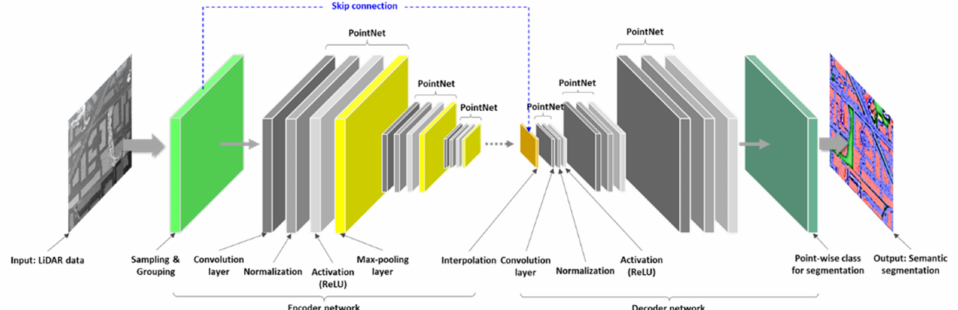
Figure 10. PointNet++ architecture showing configuration of the PointNet